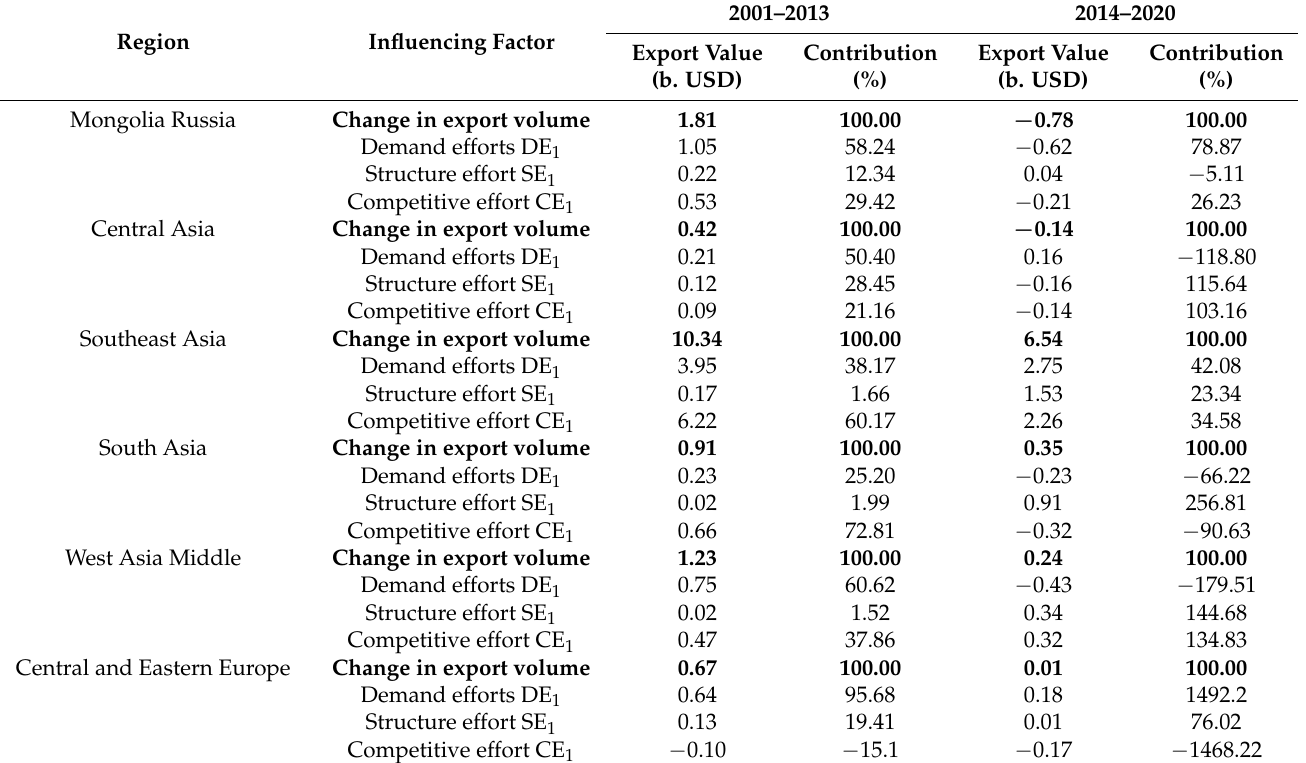
Table 3. Regional distribution of China exports agricultural to B&R countries.